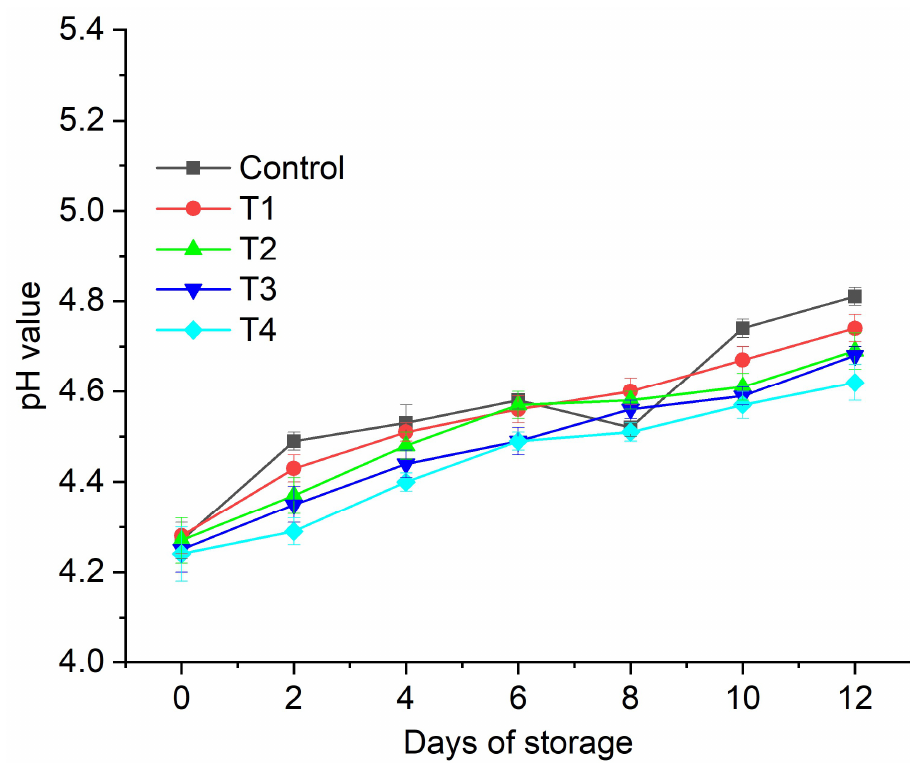
Figure 3. Effect of edible coatings on pH of Ficus carica fruits: uncoated control, AVG (T1), AVG + glycerol (T2), AVG + glycerol + anthocyanin + 0.2% (T3), and AVG + glycerol + anthocyanin + 0.5% (T4). Data are presented as mean ± SD, ( n = 3).